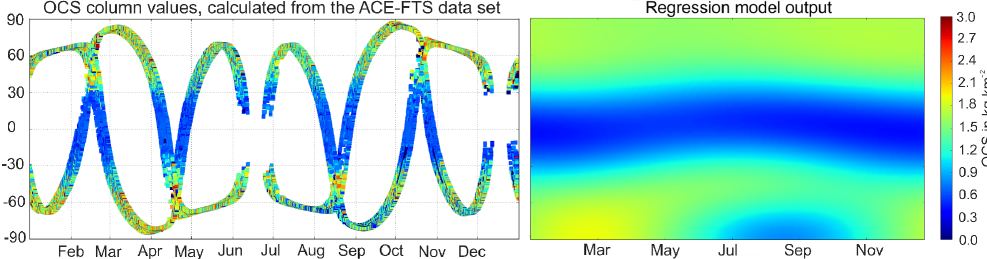
Figure 2. Stratospheric OCS column values in kgkm − 2 , which were calculated for a 1 ◦ × 1 ◦ grid using the ACE-FTS OCS data and the resulting regression model output.